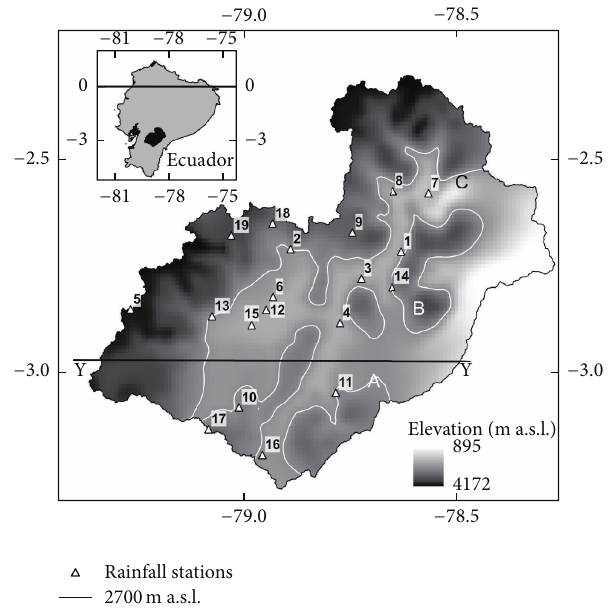
Figure 1: The Paute river basin in south Ecuador. Profile Y-Y black line. Prominent orographic features are Mount El Calvario (A), Mount Bellavista (B), and Paute canyon